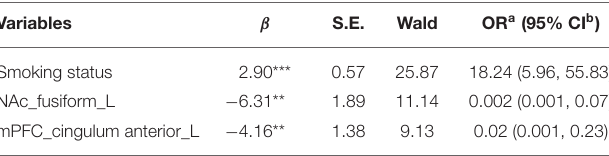
TABLE 2 | Multivariate logistic regression models using three indicators to AD ( n = 136). Variables